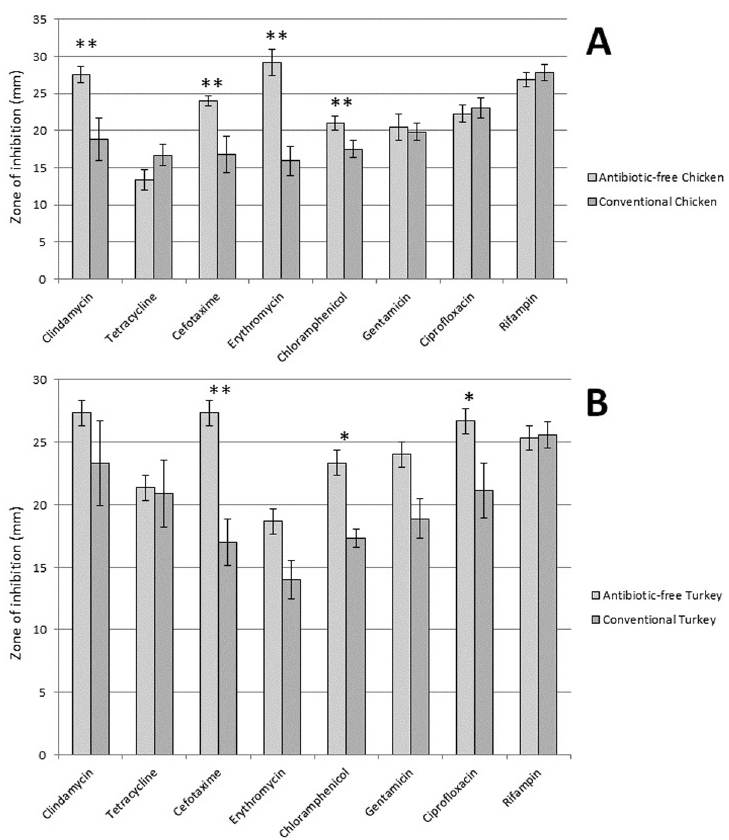
Fig 3. Antibiotic resistance levels in AF meat products as compared to conventional meat products. Panel A shows differences in antibiotic resistance in SA isolated from AF chicken products (n = 7) as compared to conventional chicken products (n = 12) and panel B shows differences in rates of antibiotic resistance in SA isolated from AF turkey products (n = 3) as compared to conventional turkey products (n = 9). A 2-sample z-test on proportions was used to determine if there were significant differences in rates of antibiotic resistance amongst the various meat types for all antibiotics tested by disk diffusion. A Fishers Exact test was used to examine significant differences in oxacillin and vancomycin resistance. � indicates p � 0.05; �� indicates p �